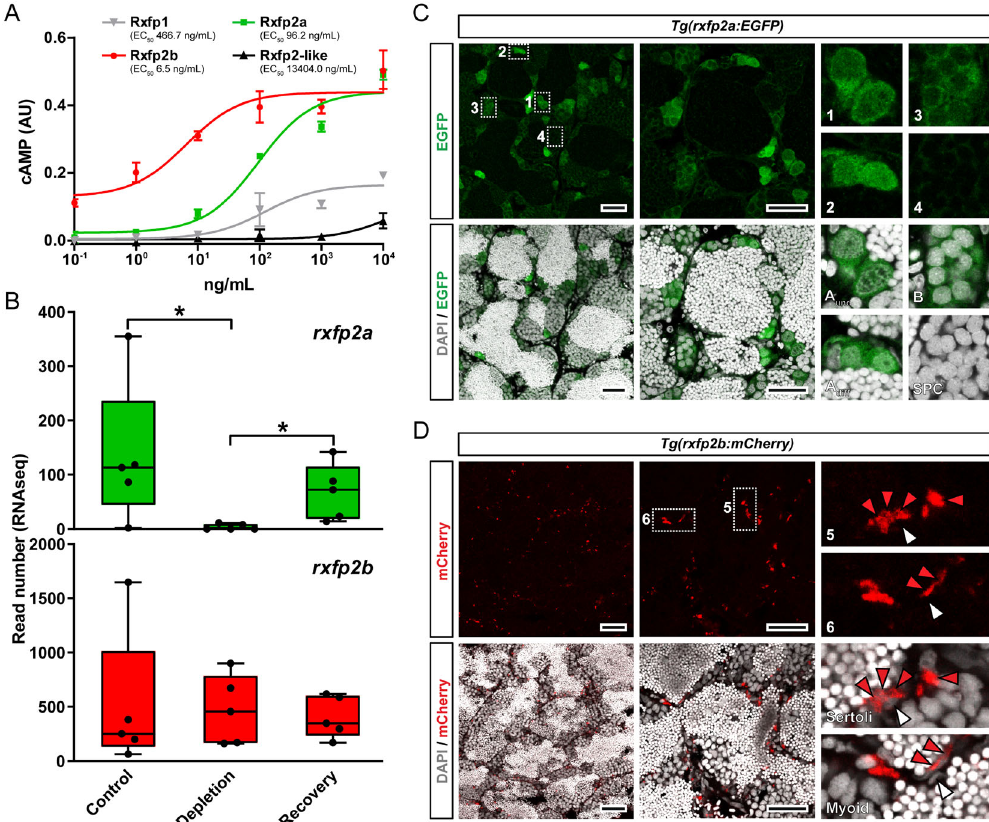
Fig. 1 Rxfp2a and Rxfp2b mediate Insl3 action in the zebra fi sh testis. A Effects of zebra fi sh Insl3 on four relaxin family peptide receptors (Rxfps) expressed in HEK293T cells transiently transfected with pcDNA3.1 and pCRE plasmids. Data are expressed as mean ± SEM ( N = 3, technical replicates). Numbers in brackets indicate the EC 50 concentrations. AU, arbitrary units. B Expression levels of responsive Insl3 receptors in control, germ cell-depleted (by exposure to the cytostatic agent busulfan 51 ), and testes with recovering (from busulfan) spermatogenesis, as described by Crespo et al. 25 (NCBI GEO data set GSE116611). Data are expressed as mean ± SEM ( N = 5; * p < 0.05). C , D Localization of rxfp2a:EGFP (green; C ) and rxfp2b:mCherry signal (red; D ) in adult testis tissue. Confocal laser scanning microscopy analysis of whole-mount testes shows preferential expression of EGFP and mCherry in type A spermatogonia and Sertoli and myoid cells, respectively. DAPI counterstain is shown in gray. Representative germ cell types (insets 1 – 4) and Sertoli and myoid cells are shown (insets 5 – 6). A und , type A undifferentiated spermatogonia; A diff , type A differentiating spermatogonia; B, type B spermatogonia; SPC, spermatocytes. In D , red and white arrowheads indicate representative mCherry + and mCherry − somatic cells, respectively. Scale bars, 25 µ